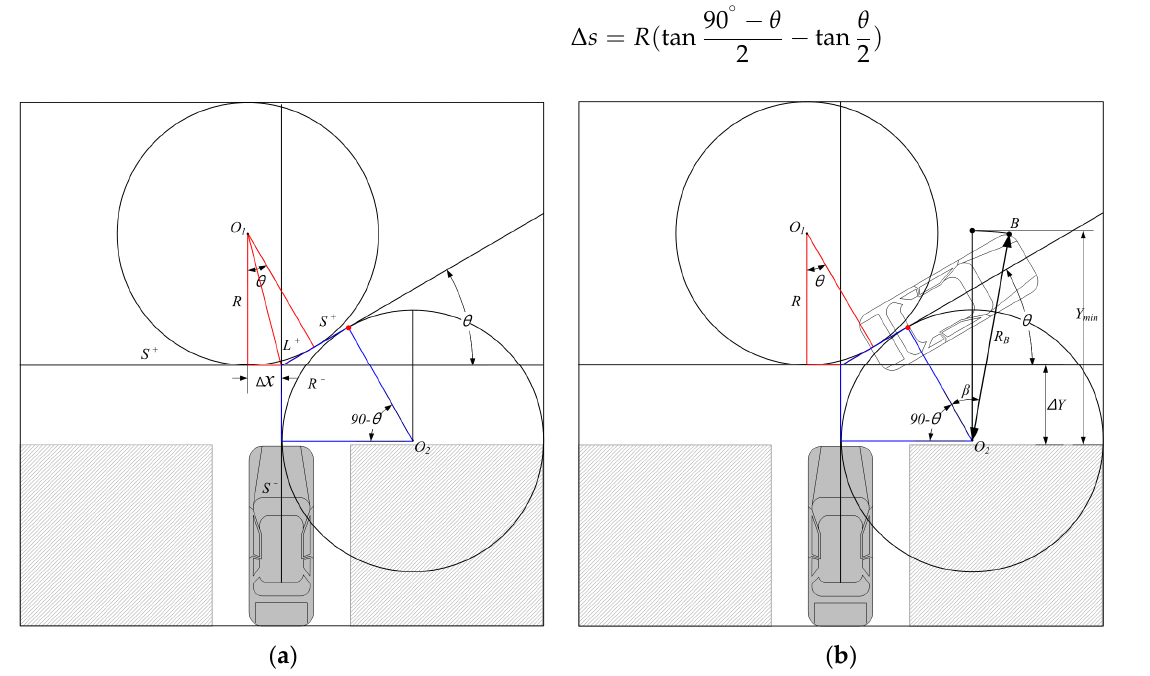
Figure 2. (𝑆 (cid:2878) 𝐿 (cid:2878) 𝑆 (cid:2878) 𝑅 (cid:2879) 𝑆 (cid:2879) ) perpendicular parking: 0° < 𝜃 < 45° : ( a ) Parking path; ( b ) surrounding space. ing